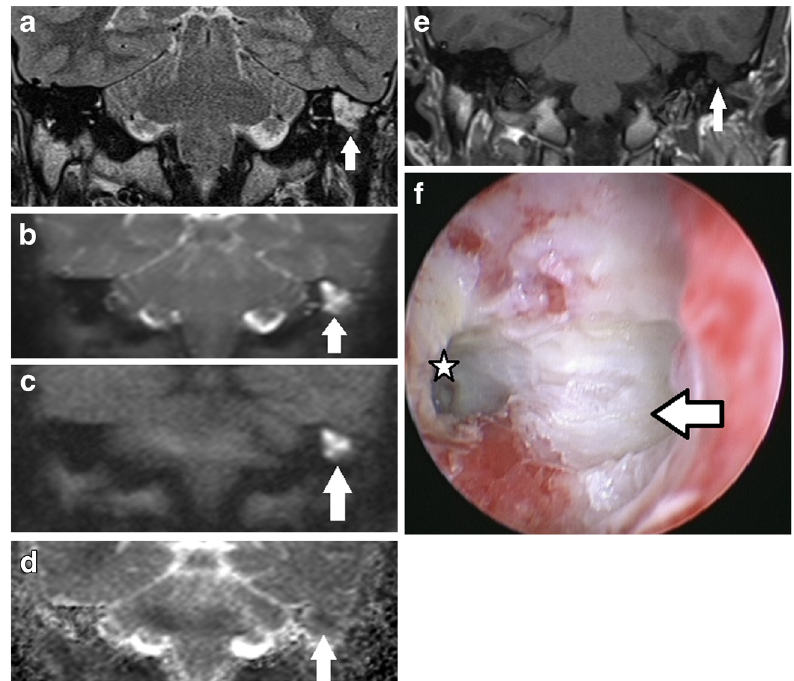
Fig. 1 Typical MRI characteristics of post-operative cholesteatoma. Coronal images through the left mastoid remnant shows the lesion ( white arrow ) as high signal on a the T2 weighted image, b DWI b0 image, and c DWI b1000 image and a low signal on the d ADC map and e non-contrast enhanced T1 weighted image. f Surgery confirms the presence of the cholesteatoma. The keratin has been suctioned away showing the underlying white squamous epithelium lining the mastoid remnant ( white arrow ) and aditus ( star